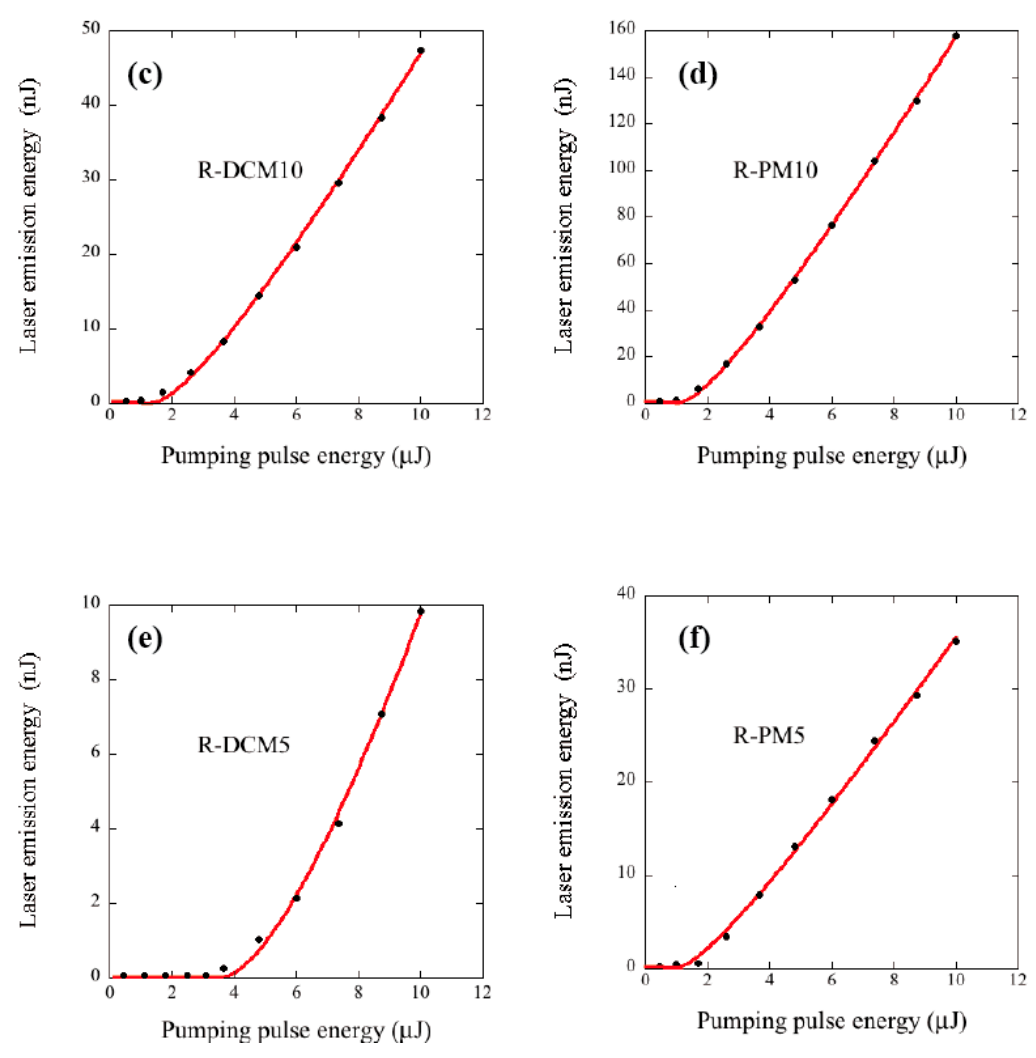
Figure 8. Laser emission energy as a function of pumping excitation energy for the different samples studied ( a – f ). Continuous lines are fits to Equation (14).